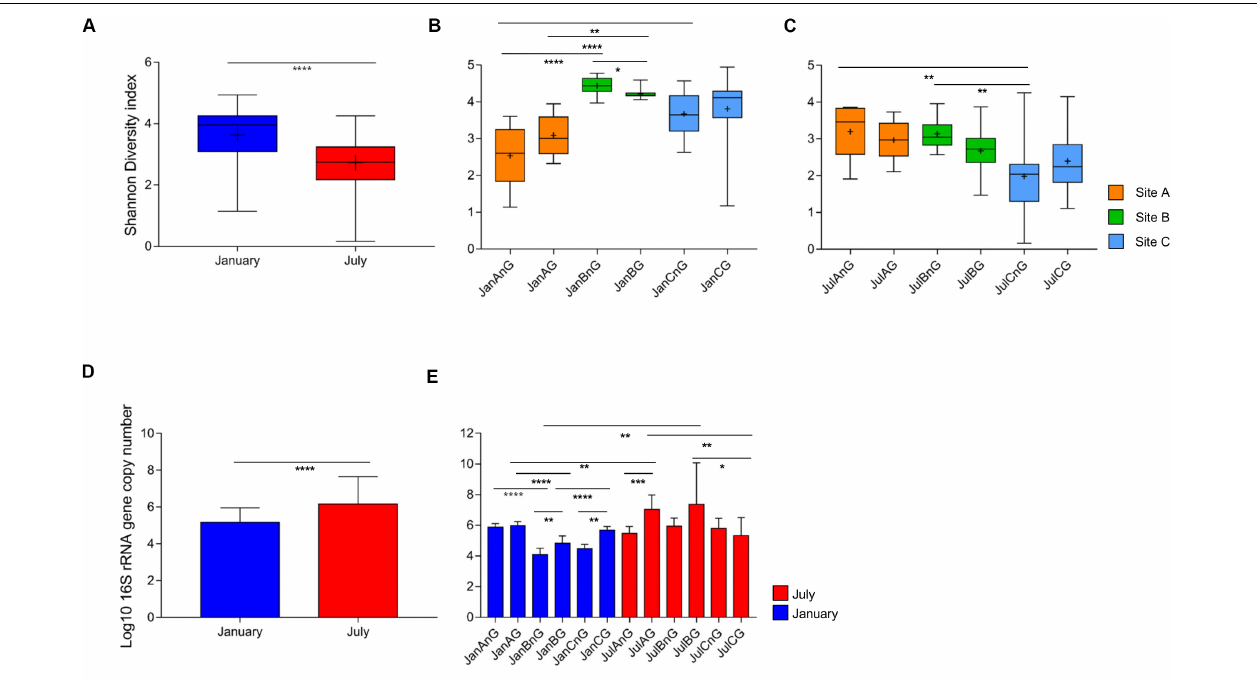
FIGURE 1 | Comparison of bacterial diversity and abundance in beef meat samples obtained from different sites and times. (A) Comparison of bacterial diversity between samples obtained in January and July. (B) Comparison of diversity indices of samples obtained in January and (C) July. (D) The average bacterial abundance was compared between samples obtained in January and July. (E) The bacterial abundance in each group was compared. The sample name indicates the sampling month, site, and processing types (for example, JanAnG; sample collected in January from site A and non-ground beef). Error bars indicate the standard deviation. * p < 0.05, ** p < 0.01, *** p < 0.001, **** p <